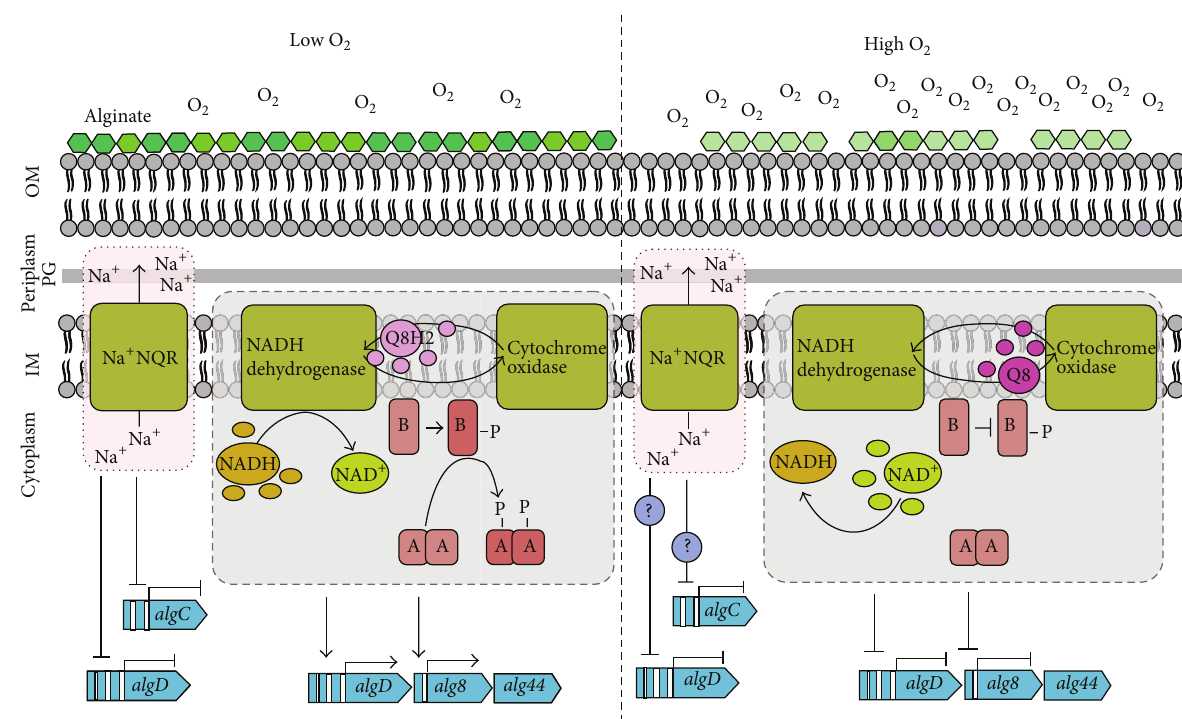
Figure 6: Schematic representation of the possible gene regulation mechanism by oxygen in Azotobacter vinelandii. Oxygen availability is depicted in the figure as low O 2 (left side) and high O 2 (right side). Light red dotted boxes indicate the Na + -translocating NADH:ubiquinone oxidoreductase (Na + NQR) that regulates negatively algD and algC gene targets, although the exact mechanism of algD and algC gene regulationathighO 2 byNa + NQRisstillunknown.GrayslashedboxesrepresenttheArcB/Atwo-componentredoxsensor:underhighoxygen availability, the autophosphorylation of ArcB (B blocks) is inhibited by oxidized quinones (Q8). ArcA (A blocks) in the nonphosphorylated state is unable to bind specifically to algD , alg8 , and alg44 gene targets. Low oxygen causes a decrease in the level of oxidized quinones (Q8H2),allowingtheautophosphorylationofArcA.ArcA-Pbindsspecificallytoitstargetsitesandcoordinatesthecellularresponsetooxygen availability. Arrows indicate positive regulation and T-shaped bars indicate negative regulation. Flag-type boxes indicate genes described in the figure. Question mark indicates unknown gene regulation mechanism. OM: outer membrane; PG: peptidoglycan; IM: inner